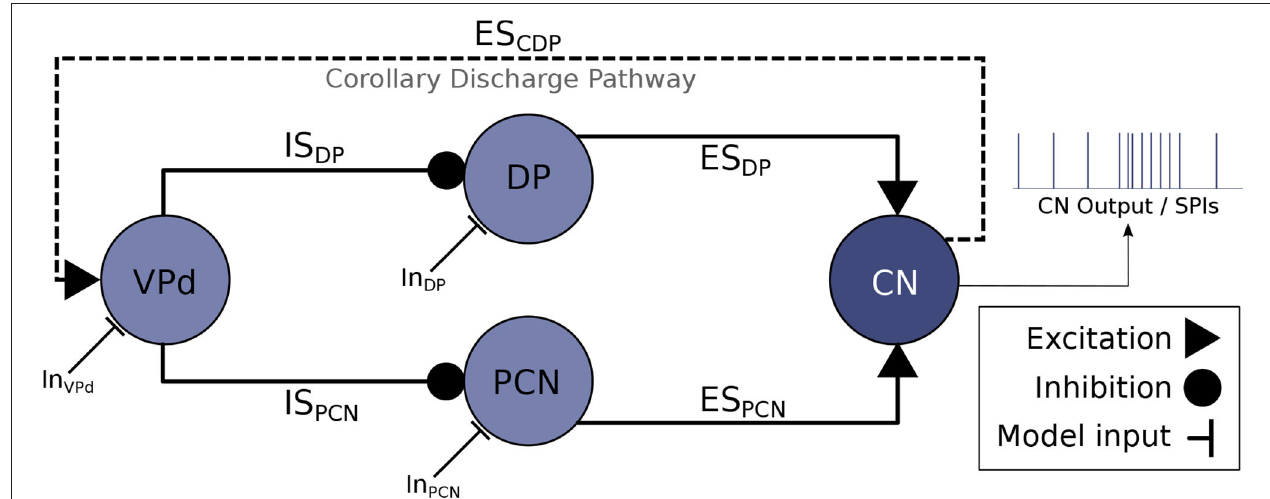
FIGURE 1 | Abridged schematic of the electromotor command network based on Bell et al. (1983) and Carlson (2003) and used for developing the computational model discussed in this article. An EOD occurs after each action potential in CN (Grant et al., 1986), thus, CN activations represent the output of the model. CN receives excitatory projections from DP (ES DP ) and PCN (ES PCN ). Inhibitory afferents are driven to DP and PCN through VPd (IS DP and IS PCN , respectively) triggered by the corollary discharge pathway (ES CDP ), which makes VPd to fire a burst of action potentials right after the production of an EOD (Carlson, 2002b). This inhibition feedback seems to regulate the rhythm of EOD output (Von der Emde et al., 2000). Current inputs to the electromotor model (In VPd , In DP , In PCN ) can be tuned to simulate different behavioral conditions that give rise to different